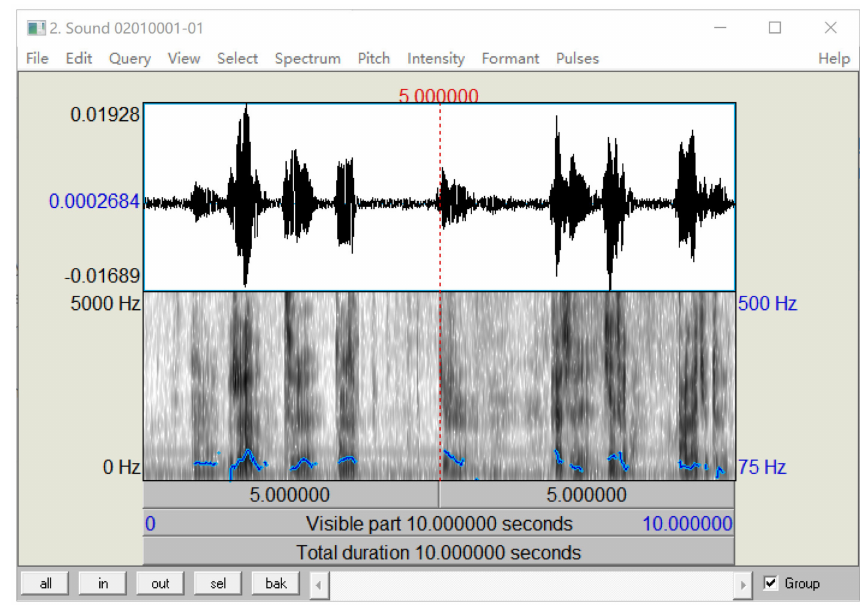
Figure 2. Visualization of voice